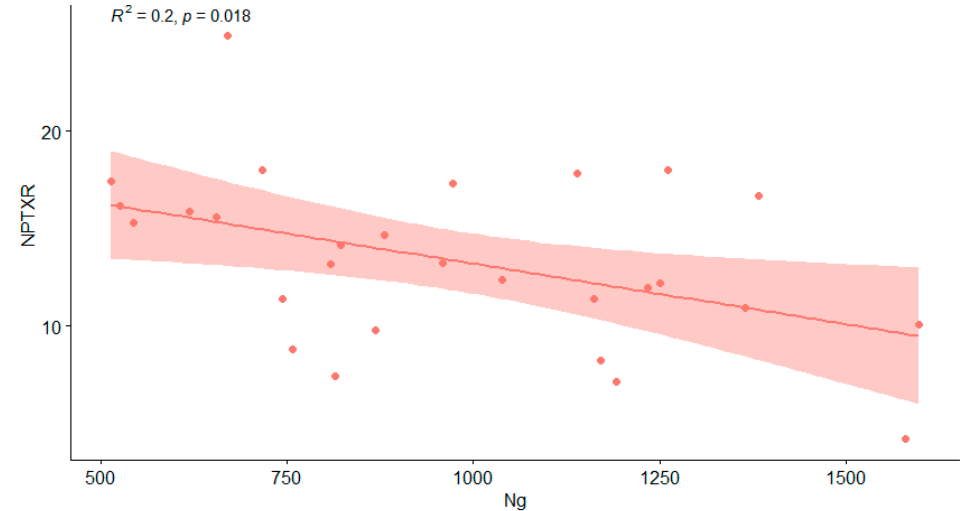
Figure 3. Correlation between CSF Ng and NPTXR levels in the AD group (showed with red dots represents results of each AD patients and line of best fit with 95% CI). Legend: NPTXR—neuronal pentraxin receptor, Ng—neurogranin, AD—Alzheimer’s disease.